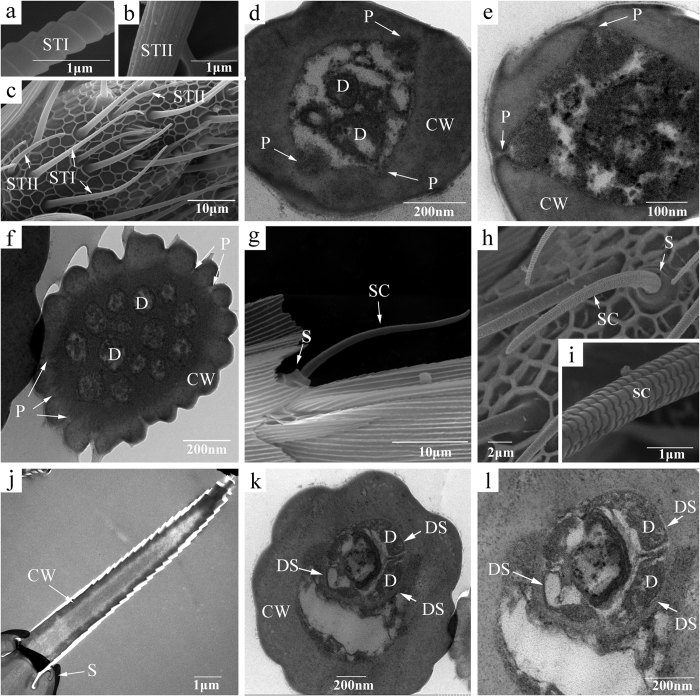
Scanning and transmission electron micrographs of sensilla trichodea (ST) and sensilla chaetica (SC) on the antennae of Sitotroga cerealella.(a,b) Surface structure of two types of ST, STI (a) and STII (b); (c) shape of STI and STII; (d,e) cross sections of STI; (f) cross section of STII; (g,h) shape of SC; (i) surface structure of SC; (j) longitudinal section of SC; (k,l) cross sections of SC. CW, cuticular wall; P, pores; S, socket; D, dendrites; DS, dendrite sheath.